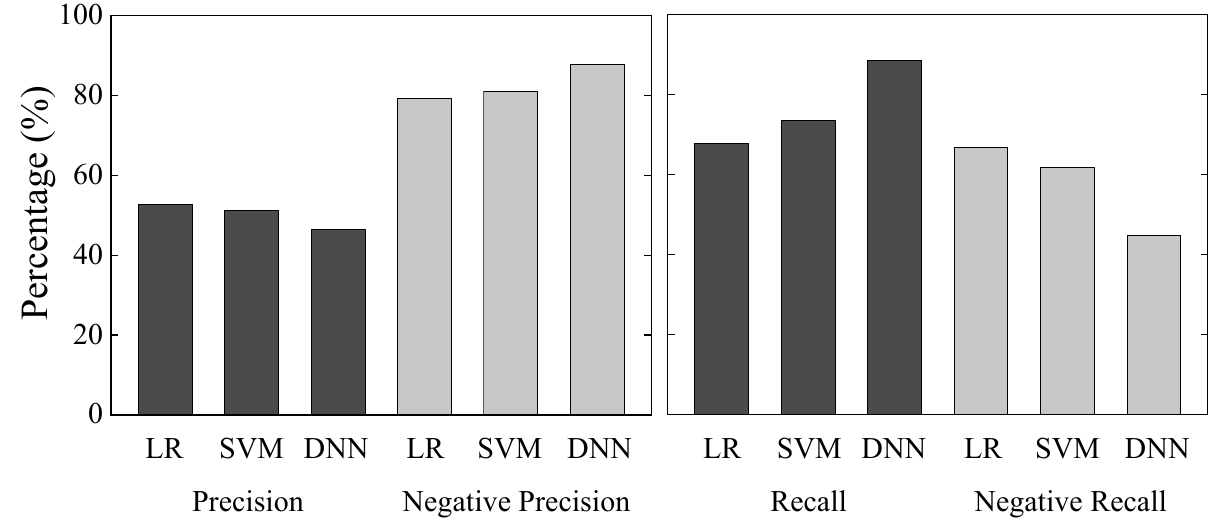
Figure 7. Comparison of Precision, Negative Precision, Recall, and Negative Recall in Section 3.4.